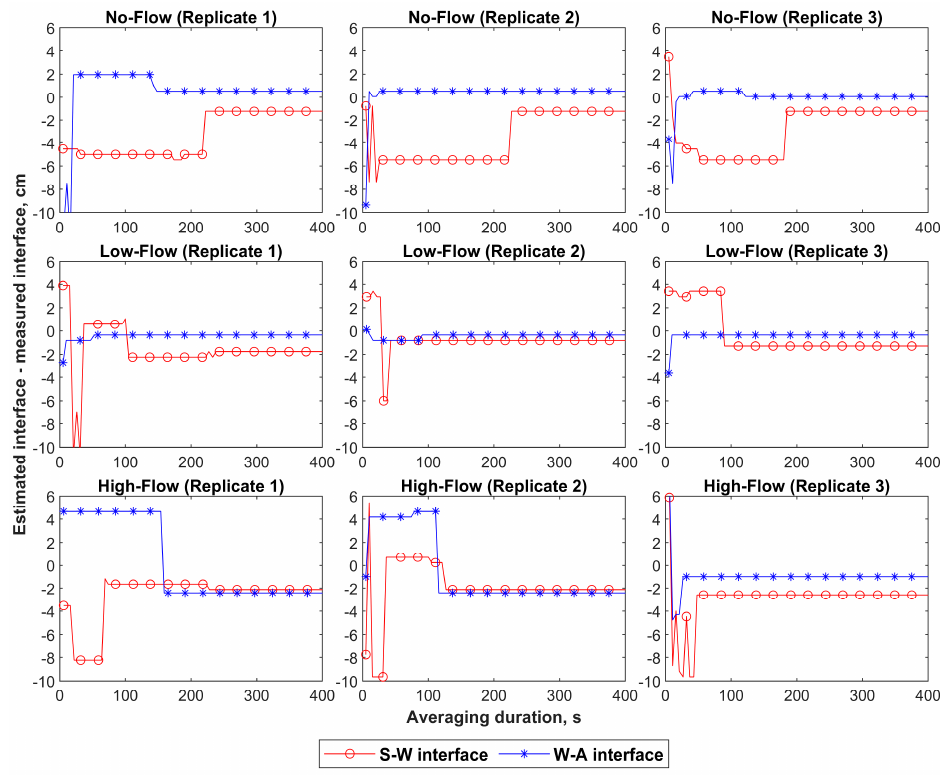
Figure 7. Errors in the detected interfaces derived from the mean temperature-increase signals over varying time intervals. The markers of the errors in the locations of the S-W and W-A interfaces are added every fi ve data points for clarity purposes.